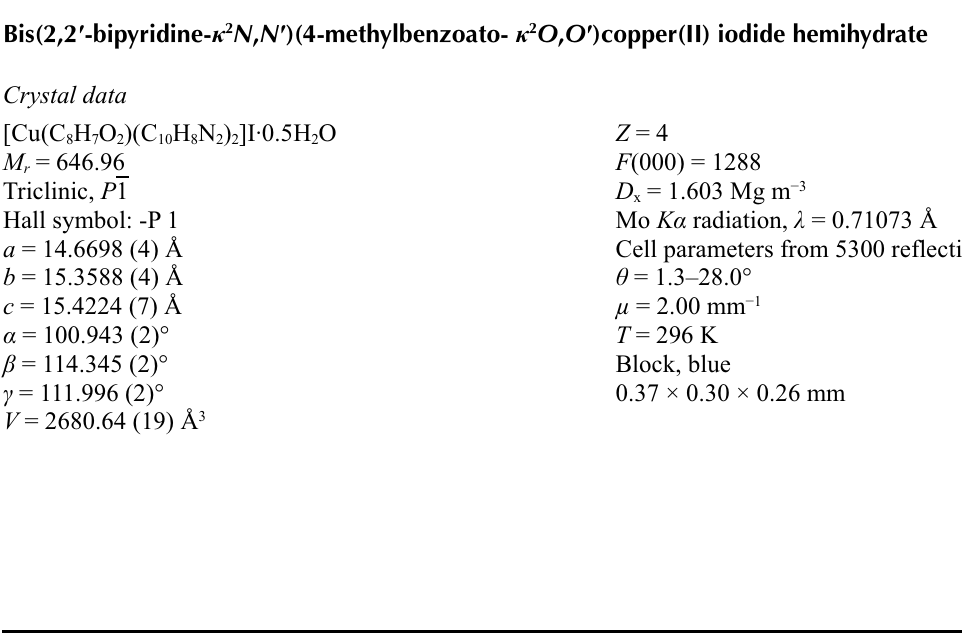
A packing view of the title compound. Hydrogen bonds are depicted as dashed